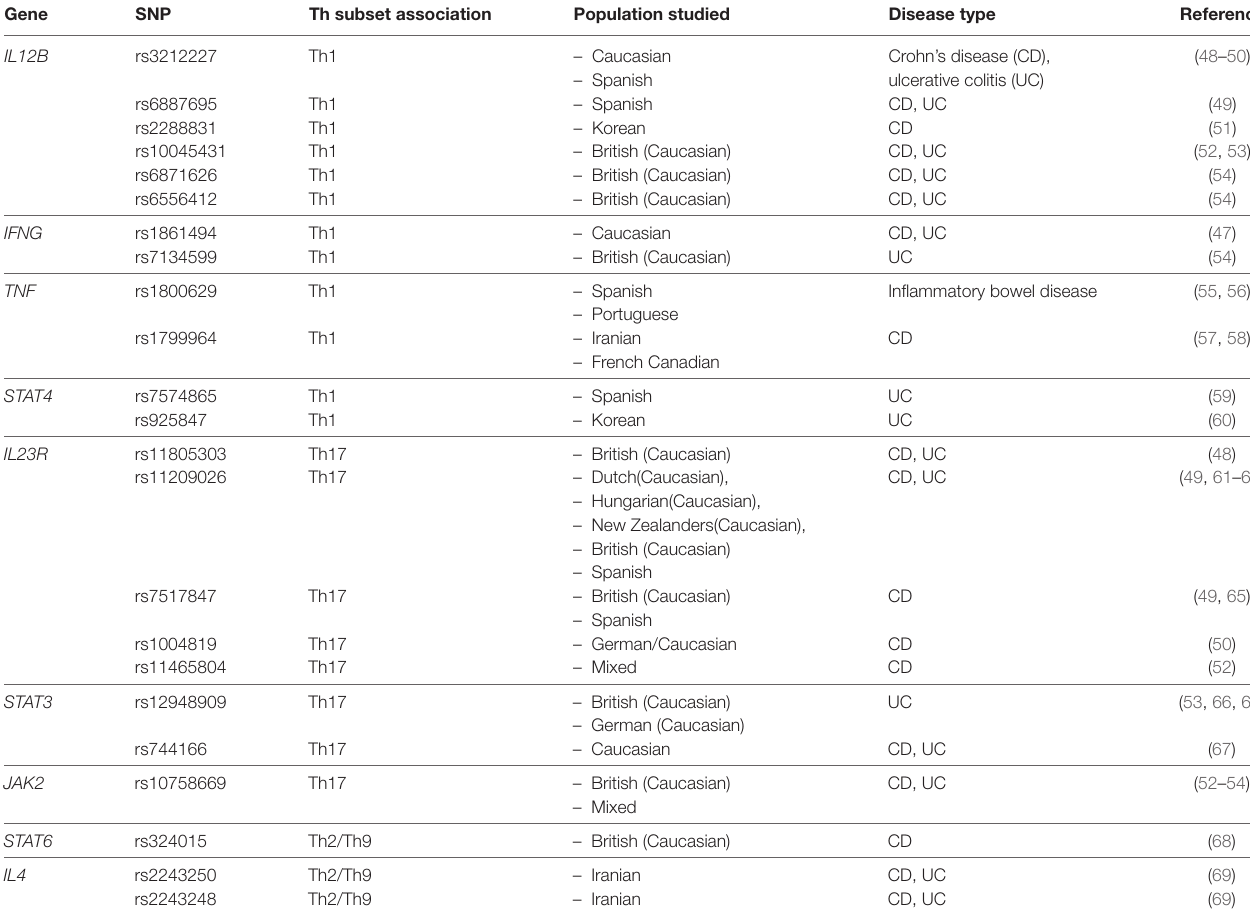
TABLe 2 | Single nucleotide polymorphisms (SNPs) associated with Th-associated cytokines or transcription factors.